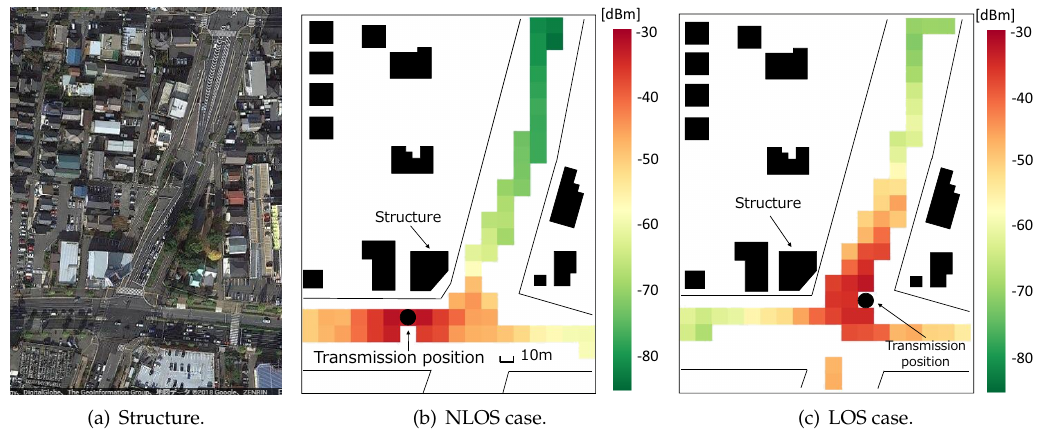
Figure 7. Examples of radio environment